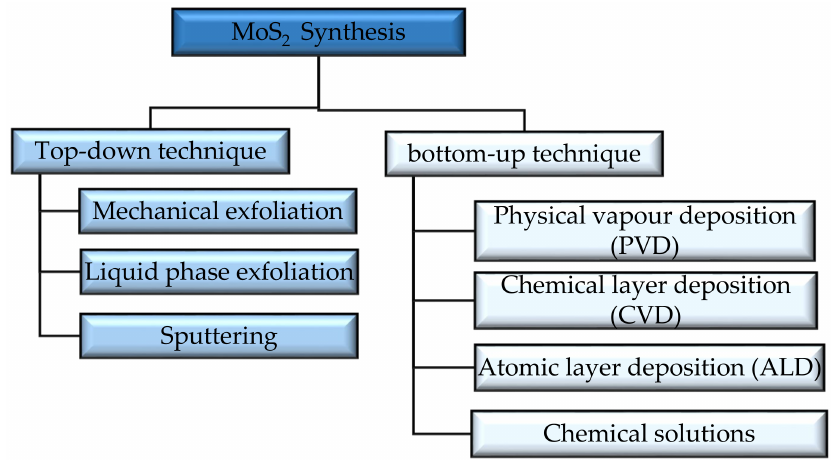
Figure 2. Different MoS 2 synthesis techniques